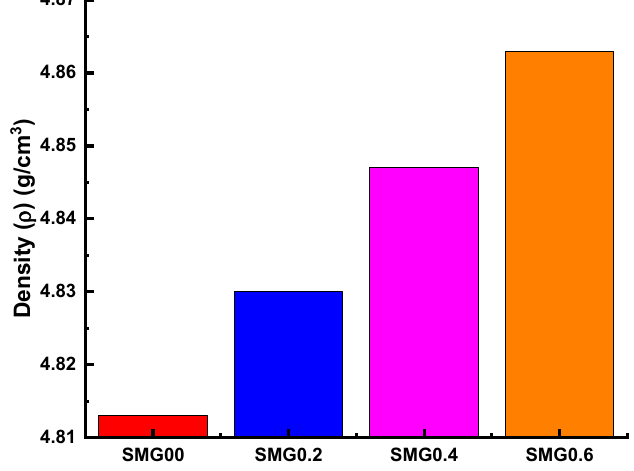
Figure 9. The density values of fabricated samples.